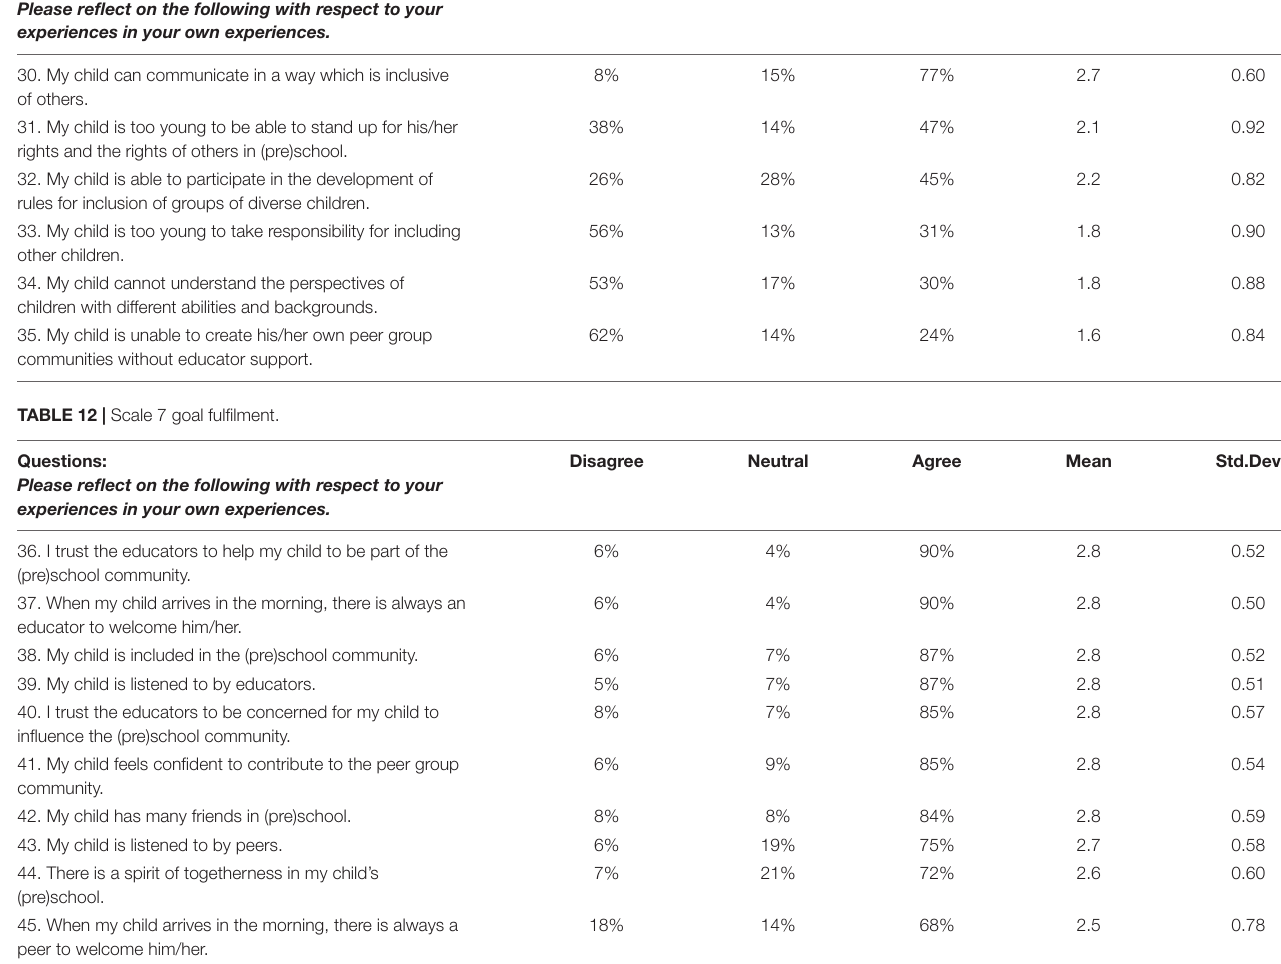
TABLE 11 | Scale 6: Parent’s opinions of the child’s ability to include and interact. Questions: Please reflect on the following with respect to your experiences in your own experiences.